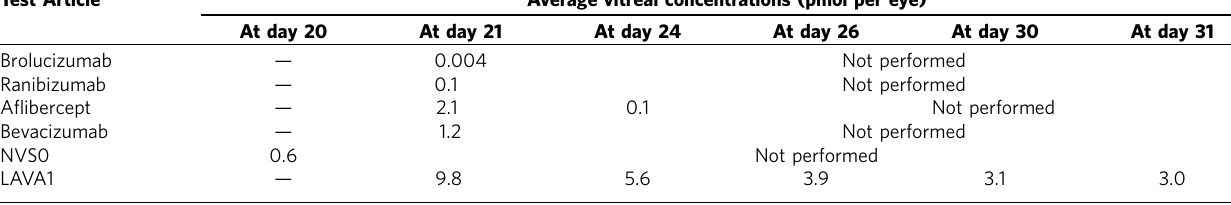
Table 1 | Terminal vitreal levels of anti-VEGF molecules from the rabbit leakage model. Test